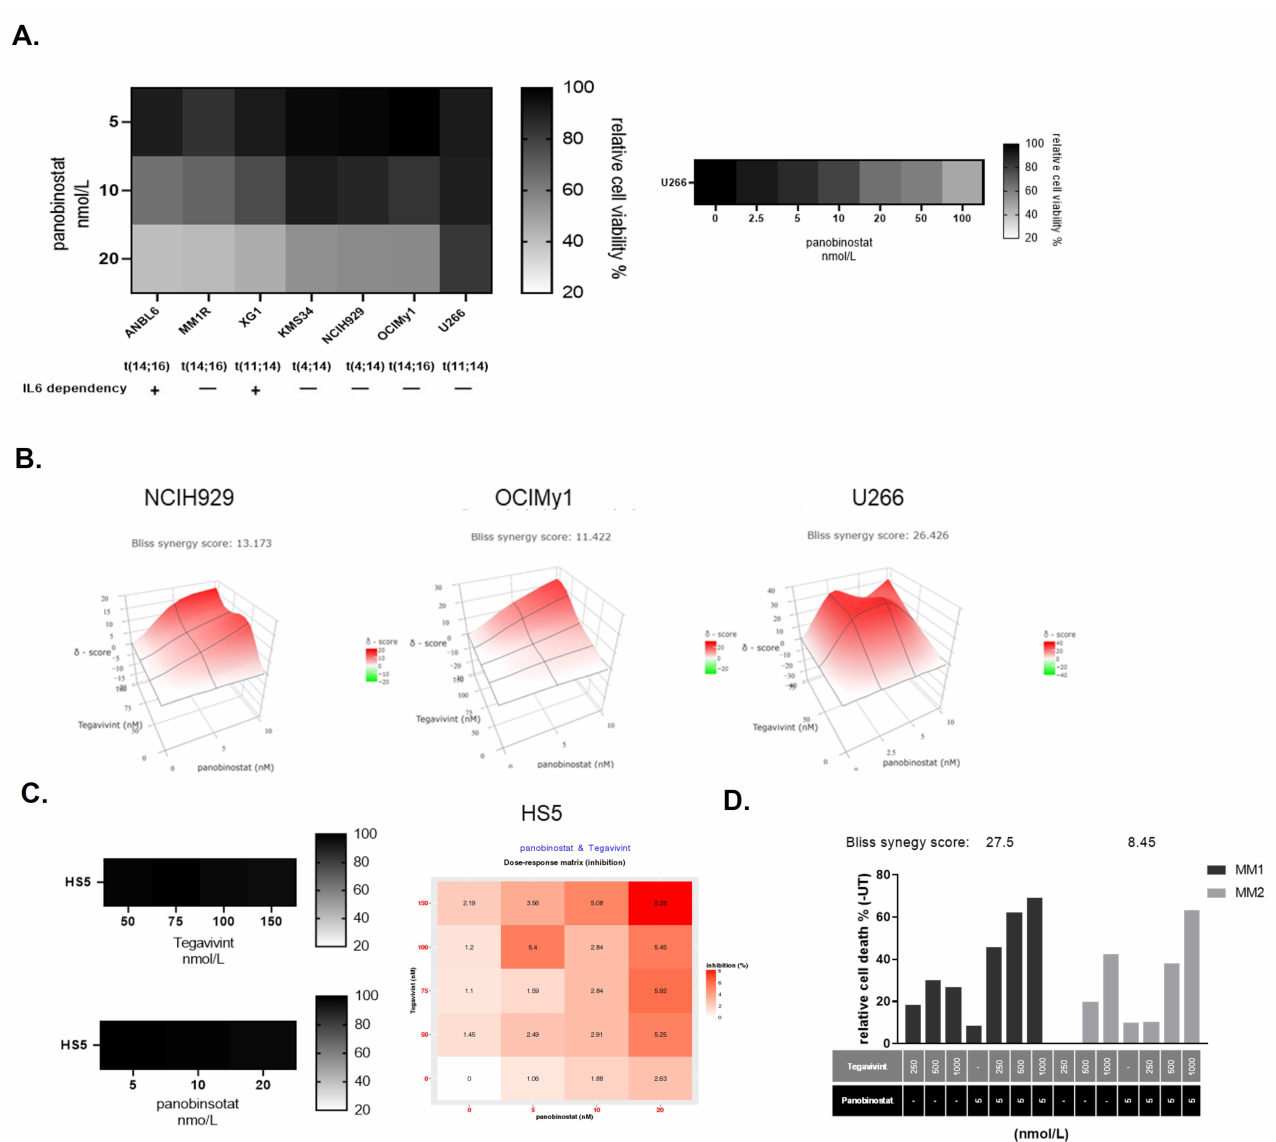
Figure 1. The combination of Tegavivint and panobinostat exerts synergistic anti-MM effects in vitro and ex vivo. ( A ) Seven HMCL were treated with clinically relevant doses of panobinostat (up to 20 nmol/L) for 48 h and PI+ was measured by FC ( n = 3–6). Cell viability was calculated as a relative percentage compared with vehicle alone (100%). U266 were further treated with increasing doses of panobinostat up to 200 nmol/L for 48 h and propidium iodide + (PI+) was measured by flow cytometry (FC) ( n = 6). ( B ) NCIH929, OCIMy1, and U266 were treated with Tegavivint, panobinsotat, or their combination for 48 h. PI+ was measured by FC ( n = 3). The expected drug combination responses were calculated based on Bliss reference model using SynergyFinder. Deviations between observed and expected responses with positive and negative values denote synergy and antagonism respectively. ( C ) Non-malignant HS5 cells were treated with similar doses of Tegavivint or panobinostat alone for 48 h and PI+ was measured by FC. Cell viability was calculated as a relative percentage compared with vehicle alone (100%) ( n = 3) (left panel). HS5 cells were treated with Tegavivint, panobinsotat, or their combination for 48 h and PI+ was measured by flow cytometry (FC) ( n = 3). Dose response matrix was produced (right panel). ( D ) Proportion of apoptotic (Apo 2.7 +) CD38 + CD45 − primary MM cells in an autologous bone marrow coculture assay after 72 h of Tegavivint, panobinostat, or the combination. Numbers represent calculated Bliss synergy scores for each patient